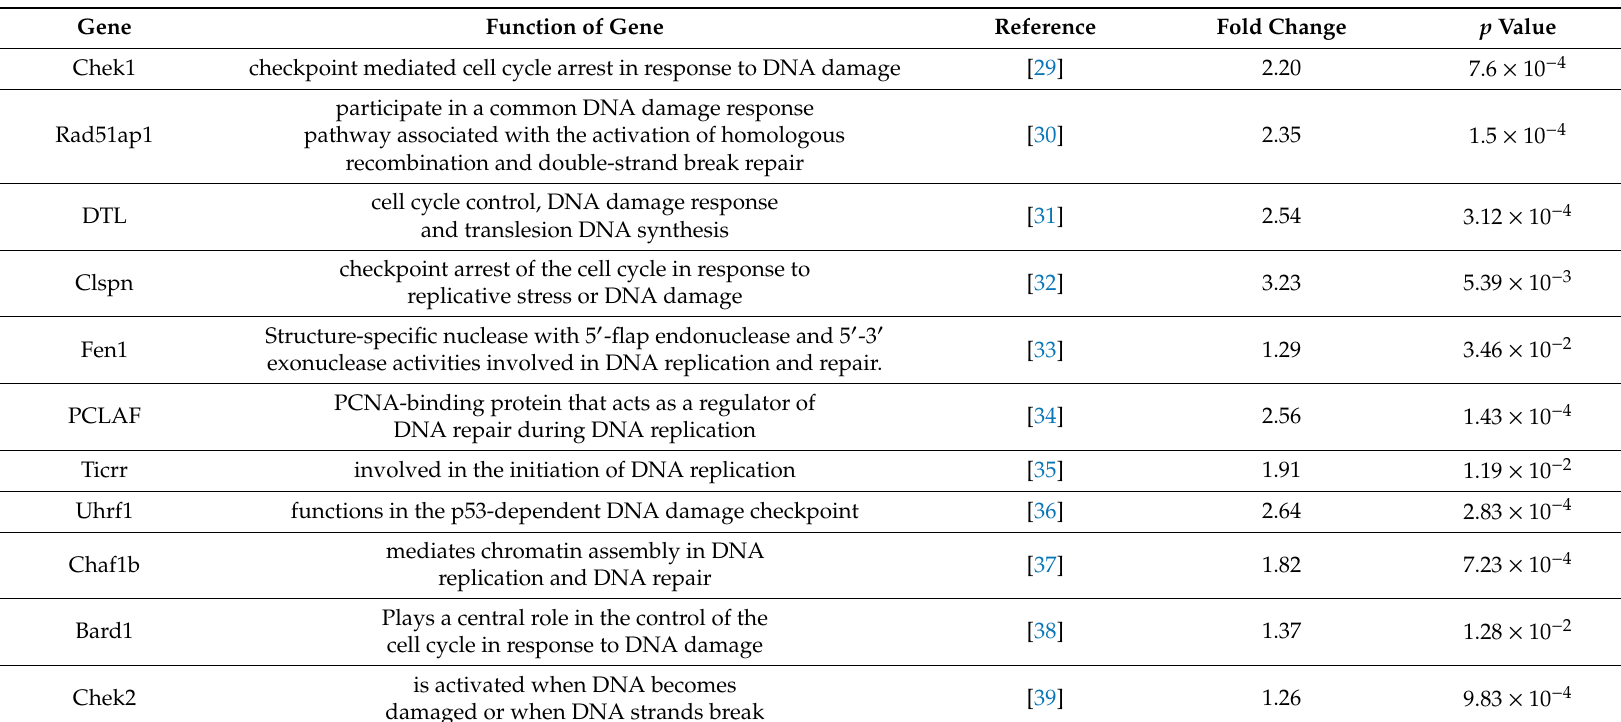
Table 3. Realtime PCR